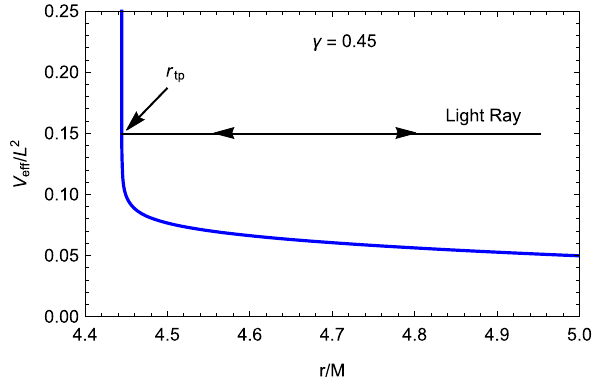
π/ 2 Fig. 2 A typical plot of V (in units of ¯ L 2 ) as a function of r (in eff units of M ) for γ = 0 . 45. A ray of light (indicated by the black line) comes from a distant source, hits the turning point at r = r tp , turns back and escapes to